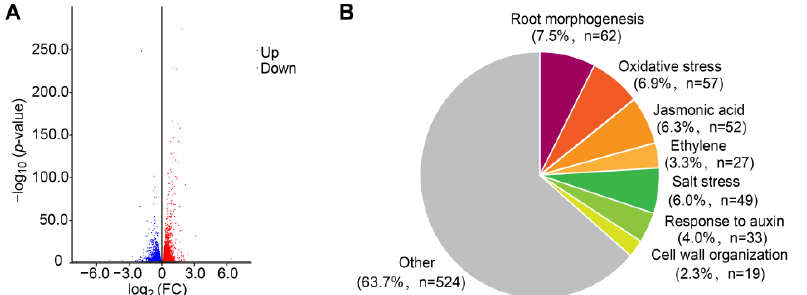
Figure 2. Whole-transcriptome analysis following FB1 exposure. ( A ) Volcano plot showing differentially expressed genes (DEGs) in wild-type seedlings treated with 2.5 μ M FB1 compared to control seedlings. The horizontal line indicates the significance threshold for DEGs ( p < 0.05). Upregulated and downregulated genes are shown with blue and red dots, respectively. ( B ) Enriched GO terms among DEGs. GO functional analysis of DEGs upon treatment with 2.5 μ M FB1 with a |Log 2 FC| > 0.585 (i.e., 935 genes). ShinyGo v0.61 software was used for the GO enrichment analysis.